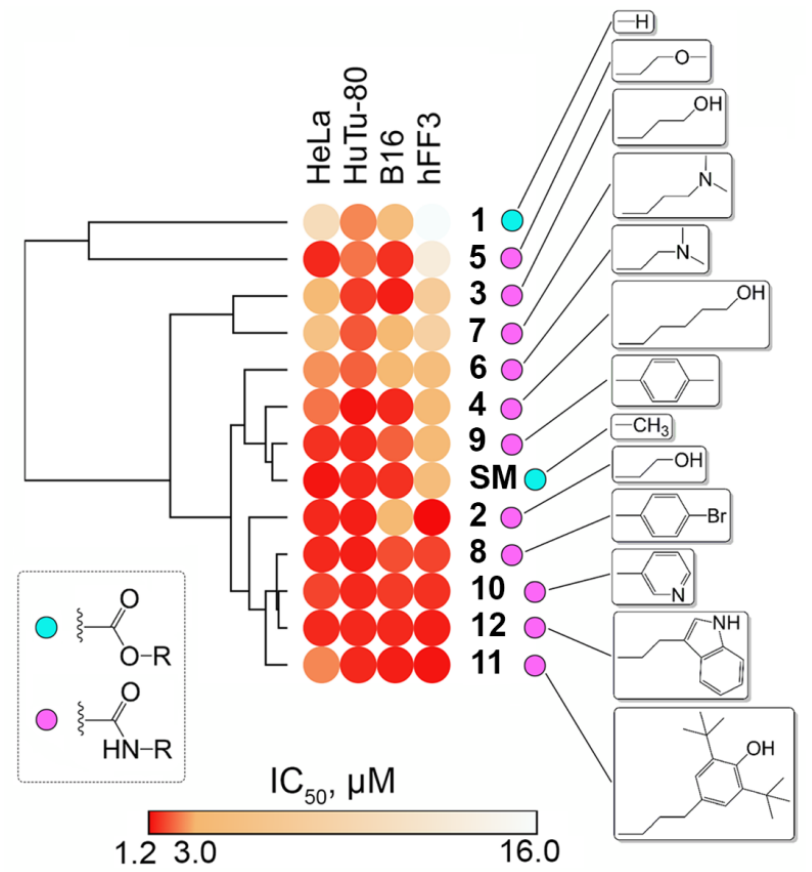
Figure 2. Cytotoxic profiles of novel soloxolone amides. Hierarchical clusterization of cytotoxic data was performed using a Euclidean distance algorithm and visualized by the Morpheus tool [37].